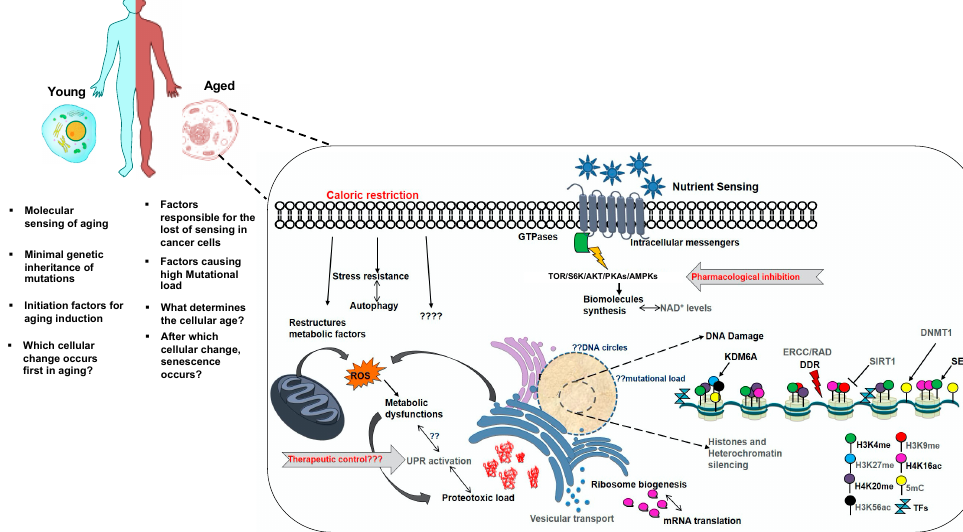
Figure 5. Aging-associated changes occurring at cellular levels. Pathways represented in aged cells in black are up-regulated and severely affect the longevity of organisms, pathways/factors represented in dark grey are down-regulated/non-functional in aged cells. Some of the aging interventions are represented in red color. Question marks in some of the pathways represent obscure feedback/forward mechanisms.